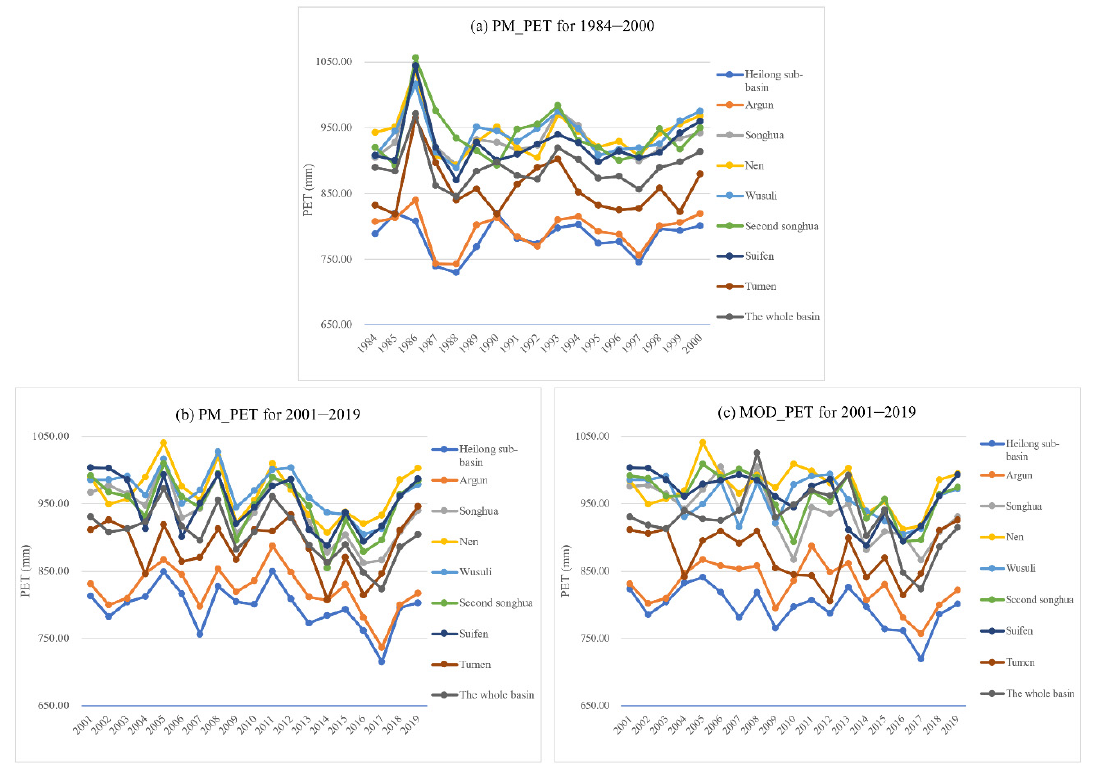
Figure 3. Interannual variation of Penman–Monteith potential evapotranspiration (PM_PET) and MOD16 potential evapotranspiration (MOD_PET) mean values for the whole basin and its sub-basins from 1984 to 2019: ( a ) PM_PET (1984–2000); ( b ) PM_PET (2001–2019); and ( c ) MOD_PET (2001–2019).